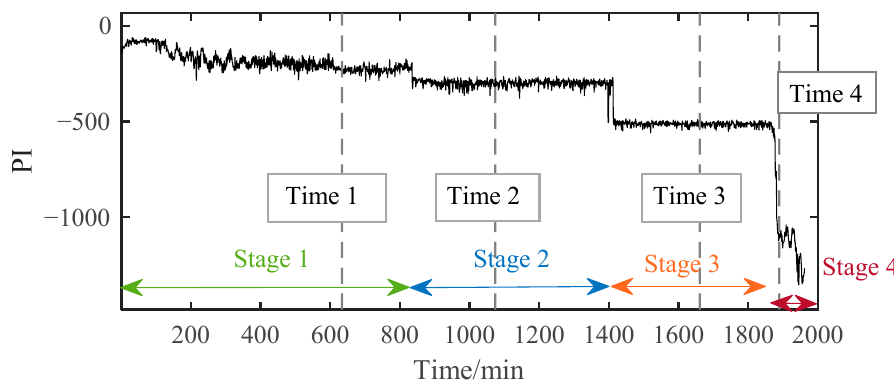
Figure 13. The PI results of B2 based on SC-RMI and Student’s t-HMM. The time plots and envelope spectra of four representative moments are shown in Figures 14 and 15. At Time 1, any fault shock characteristic could not be observed from both the time plot and the envelop spectrum. For signals at Time 2 and Time 3, they were quite similar to each other in both time plots and envelop spectra. The amplitudes at rotating frequency and its harmonic frequency were quite outstanding compared with Time 1, and the amplitudes at BPIF were still unclear. However, the amplitude distributions in the frequency domain were different between them. So, different degradation stages could be separated for Stage 2 and Stage 3. At Time 4, obvious periodic shock could be observed in the time plot, and the amplitudes at the rotating frequency and BPIF were quite obvious, which matched the characteristics of the bearing inner race fault signal. B2 did eventually fail for the inner race fault, as shown in Figure 16, which was the failure mode similar to bearing B1. Therefore, the selected features were proved to be effective for the performance degradation process of B2 too.